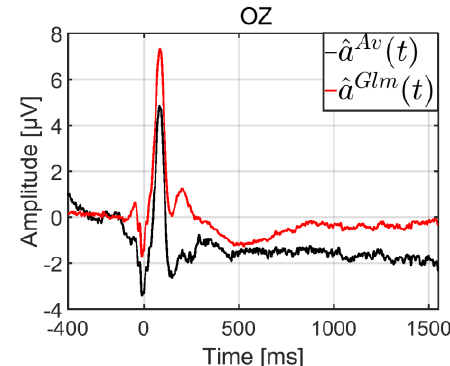
Figure 11 Grand average for the two methods: Average ( 𝑎̂ 𝐴𝑣 (𝑡) ), and GLM ( 𝑎̂ 𝐺𝑙𝑚 (𝑡) ) on the OZ